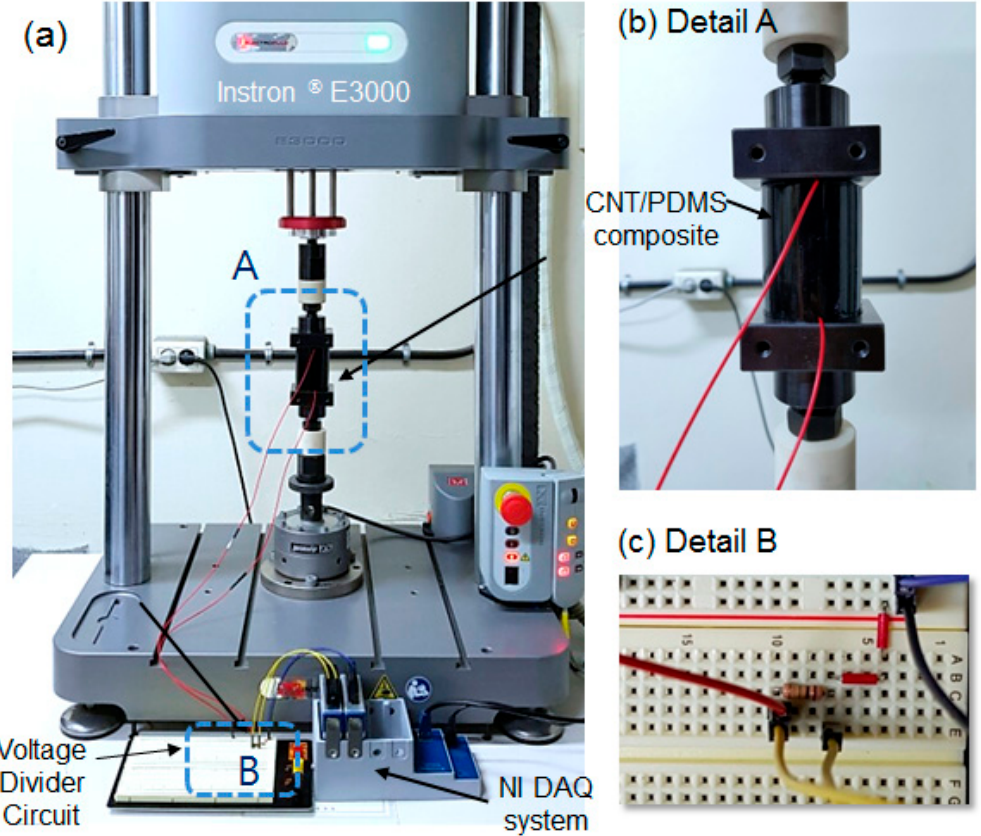
Figure 6. Photographs of the experimental setup: ( a ) overall configuration; ( b ) CNT/PDMS composite sample, and ( c ) voltage divider circuit.